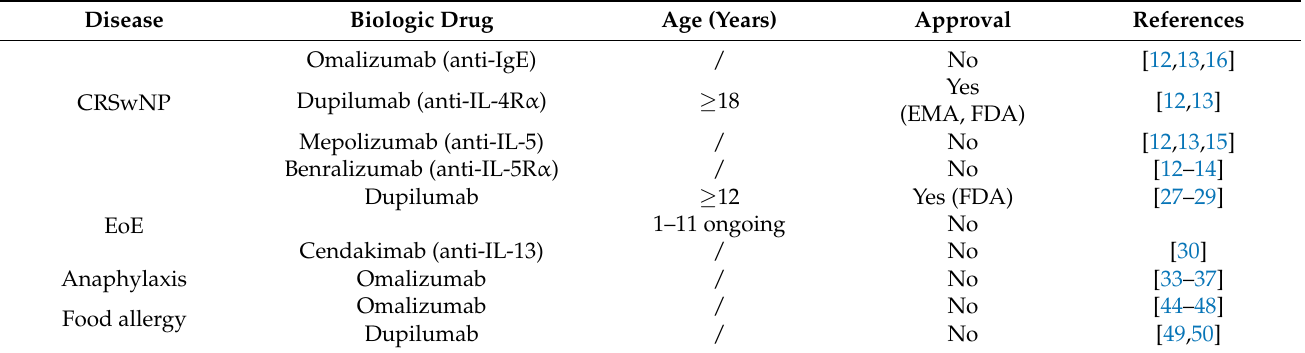
Table 1. Main biologics currently approved and on study in allergic and immunologic diseases in children. CRSwNP = chronic rhinosinusitis with nasal polyps; EoE = eosinophilic esophagitis; IL =